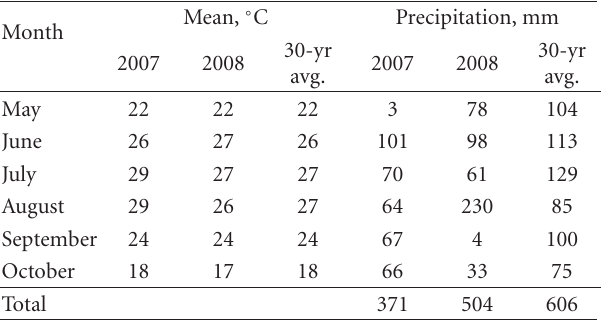
Table 1: Monthly mean air temperatures and precipitation for May–October 2007 and 2008 and 30-year averages for Marion Junction,